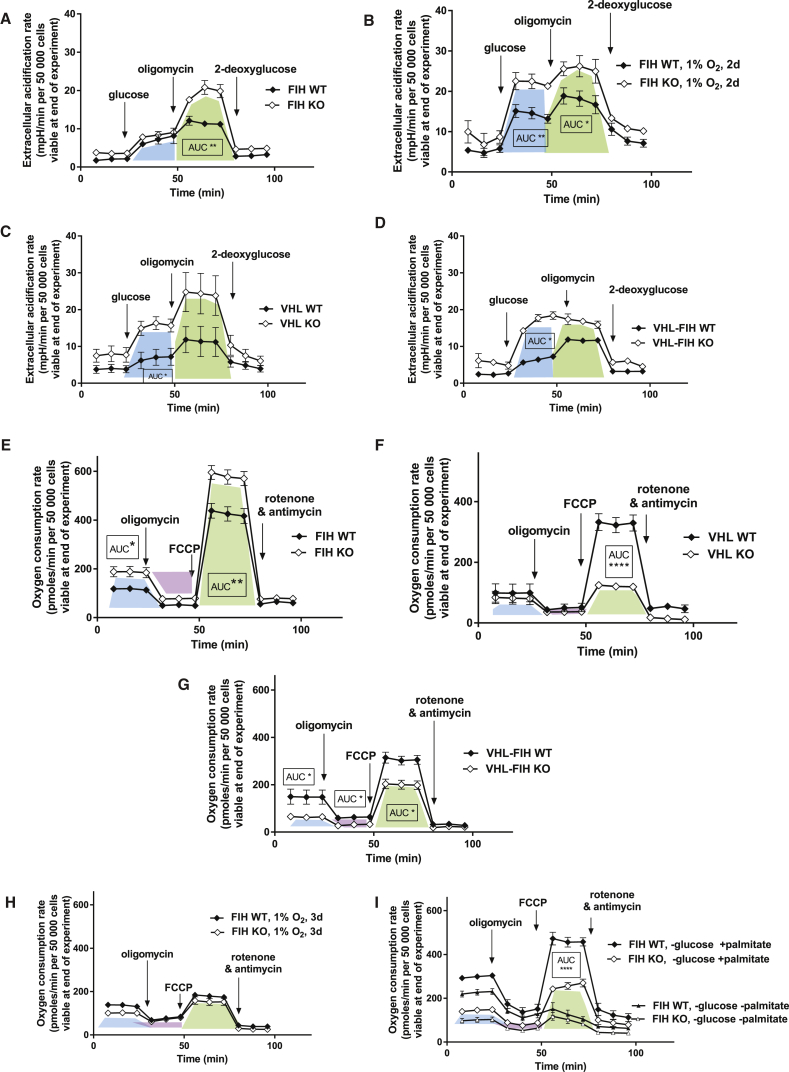
FIH Specifically Determines Glycolytic Reserve and Uncoupled Oxygen Consumption(A) Glycolytic stress test on FIH KO MEFs in 21% oxygen. The area under the curve (AUC) for each genotype was compared with a two-tailed t test. The blue polygon represents the response to glucose supplementation after a period of glucose starvation, i.e., baseline glycolysis. The green polygon is proportionate to the glycolytic reserve, unmasked upon ATP synthase inhibition.(B) Glycolytic stress test repeated on FIH KO MEFs under 1% oxygen after 3 days in hypoxic culture.(C) Glycolytic stress test, on vHL-KO MEFs in 21% oxygen.(D) Glycolytic stress test on vHL-FIH double-KO MEFs.(E) Oxidative stress test. The AUC for each genotype was compared with a two-tailed t test. The blue polygon represents baseline oxygen consumption. The purple polygon is proportionate to ATP-coupled oxygen consumption. The green polygon is proportionate to uncoupled oxygen consumption, unmasked on FCCP addition.(F) Oxidative stress test. Uncoupled VO2 is in contrast reduced in vHL KO MEF populations in normoxia.(G) Oxidative stress test. vHL/FIH double-KO MEFs resemble vHL KO MEFs in that they also have reduced uncoupled VO2 values.(H) Oxidative stress test repeated under 1% oxygen after 3 days of hypoxic culture.(I) Modified oxidative stress test using a glucose-depleted, palmitate-abundant substrate medium.∗p < 0.05, ∗∗p < 0.01, ∗∗∗∗p < 0.0001. OCR and ECAR data are represented as means ± SEM. n = 3 independent cell culture samples per genotype. The AUC for every three readings (represented by a single polygon) was computed, and a two-tailed Student's t test was applied for each pair of AUCs compared. See also Figure S3.